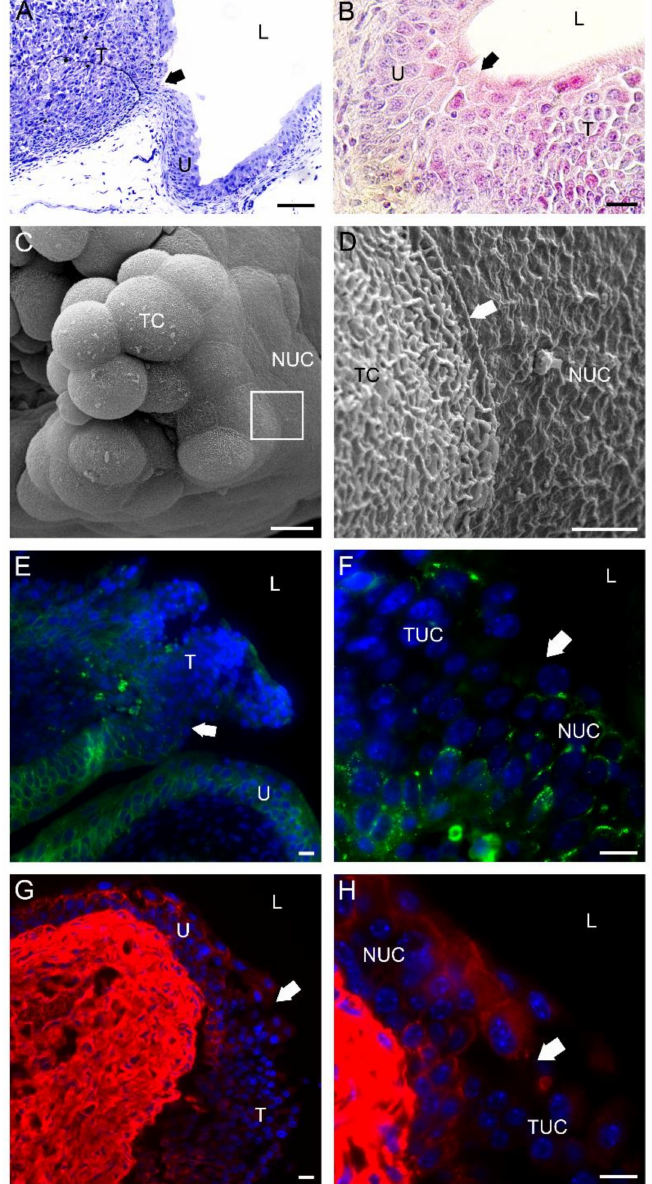
Figure 7. Characteristics of a bladder tumor margin 3 weeks after intravesical application of MB49- GFP cancer cells. ( A ) Semi-thin section of a bladder tumor with an easily recognized margin